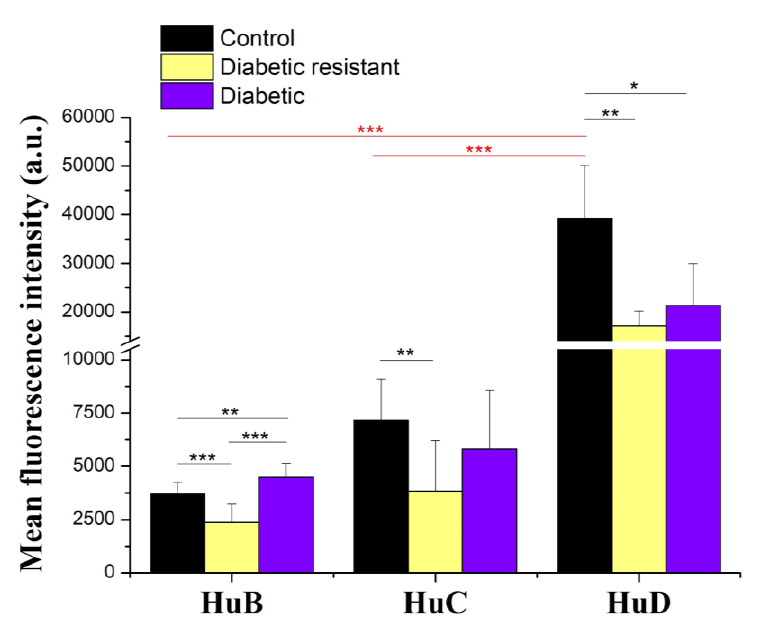
Figure 6. Hu protein expression based on mean fluorescence intensity analysis in DRG neurons of control, diabetic resistant, and diabetic mice. Data are expressed as mean ± SD in the captured images. Statistical significance is indicated * p < 0.05, ** p < 0.01, *** p < 0.001.